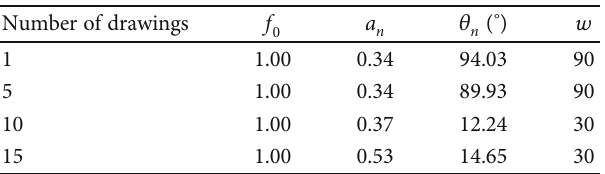
Figure 12: Statistical distribution of the normal contact force between particles under di ff erent iterations of ore drawing. Table 4: Fitting results of the normal contact force distribution in the ore drawing